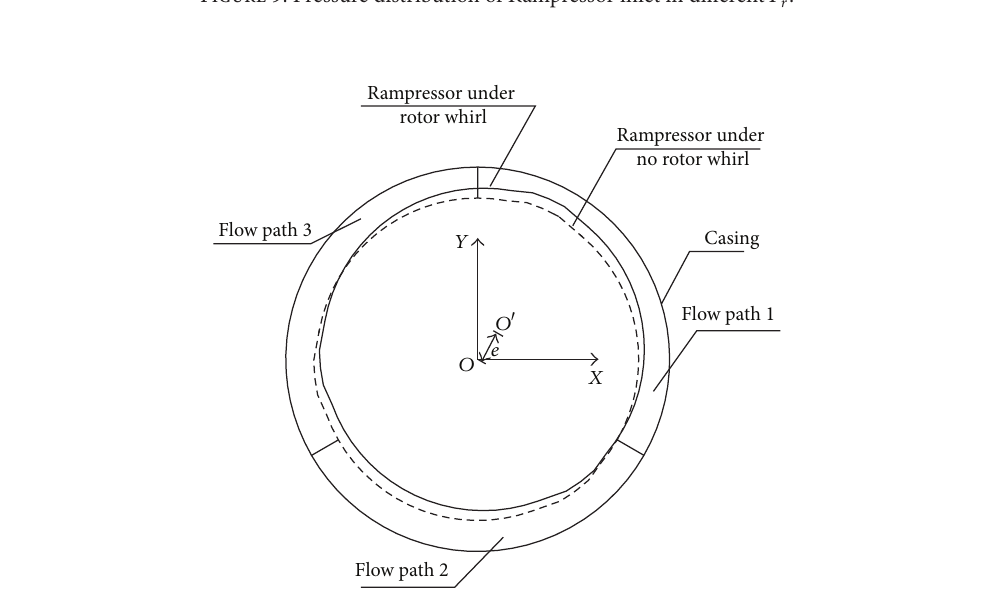
Figure 9: Pressure distribution of Rampressor inlet in different 𝑃 𝑟 .